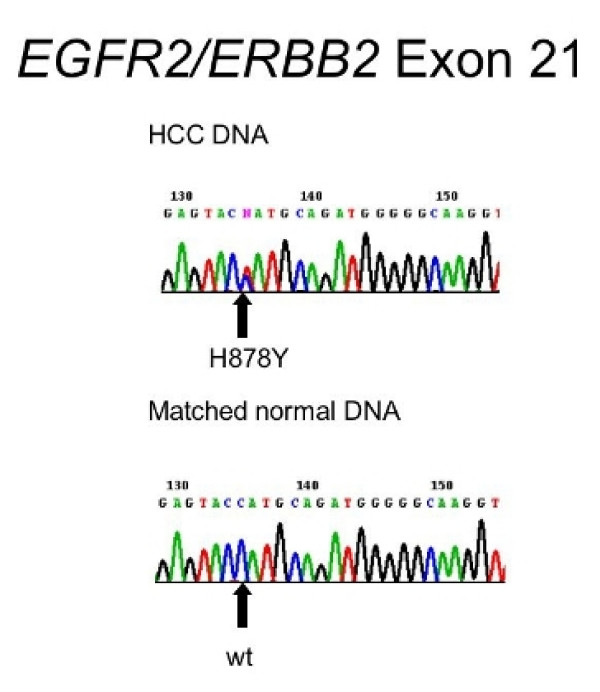
Somatic missense mutation, H878Y, found in genomic DNA from hepatoma (top chromatogram) but not in corresponding normal tissue (bottom panel).